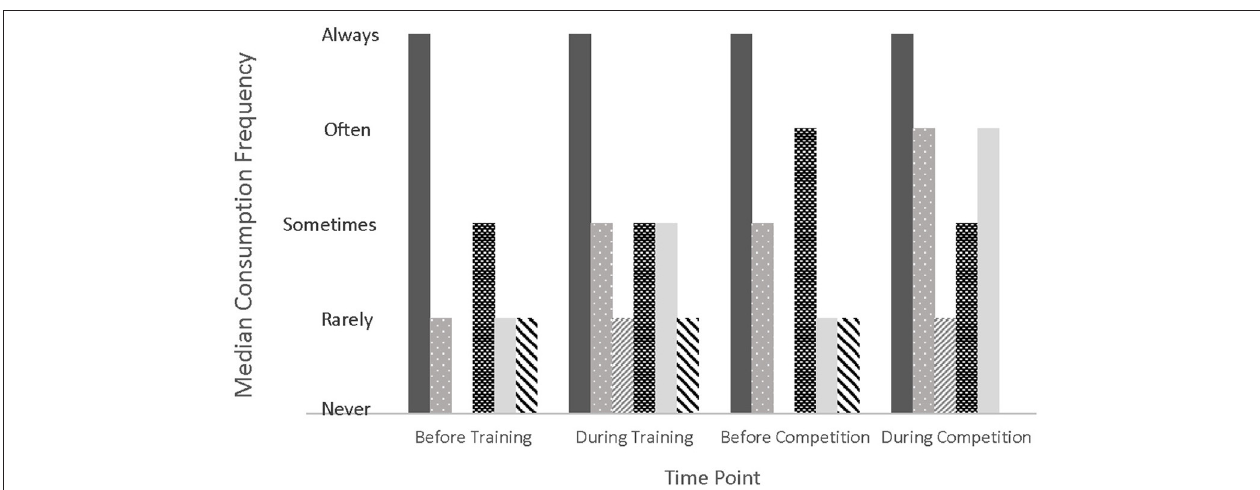
FIGURE 2 | Median consumption frequency of nutrition product categories at various time points surrounding exercise. Product categories include water (solid dark gray), sports drink/thirst quencher (light gray with polka dot), sports drink/energy drink (light gray diagonal stripe), solid foods (black with white rectangles), gel/gummy (solid light gray), homemade product (black diagonal